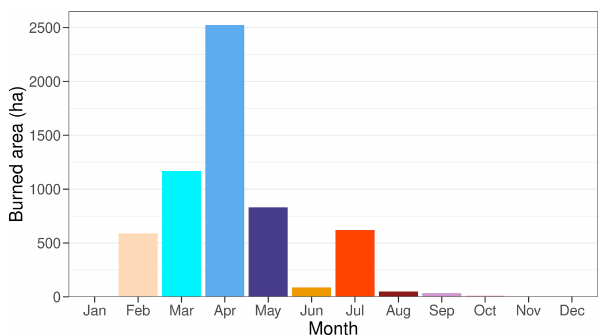
Figure 4. Annual percentage of spring (March–April–May) days, 1979–2020, averaged over the UK, with high fire danger (ISI > 5), based on ERA5 reanalysis data.